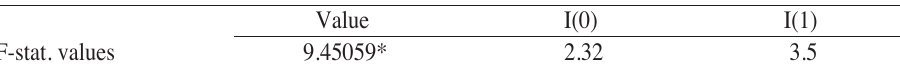
Bound Test Outcomes